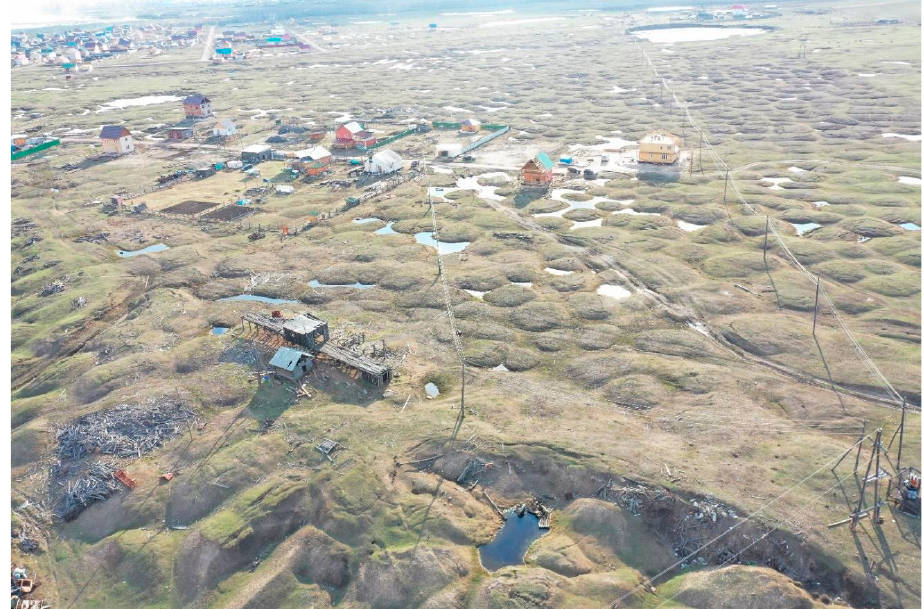
Figure 2. Thermokarst microrelief formed as a result of the thermokarst processes (permafrost degradation) in the study area.